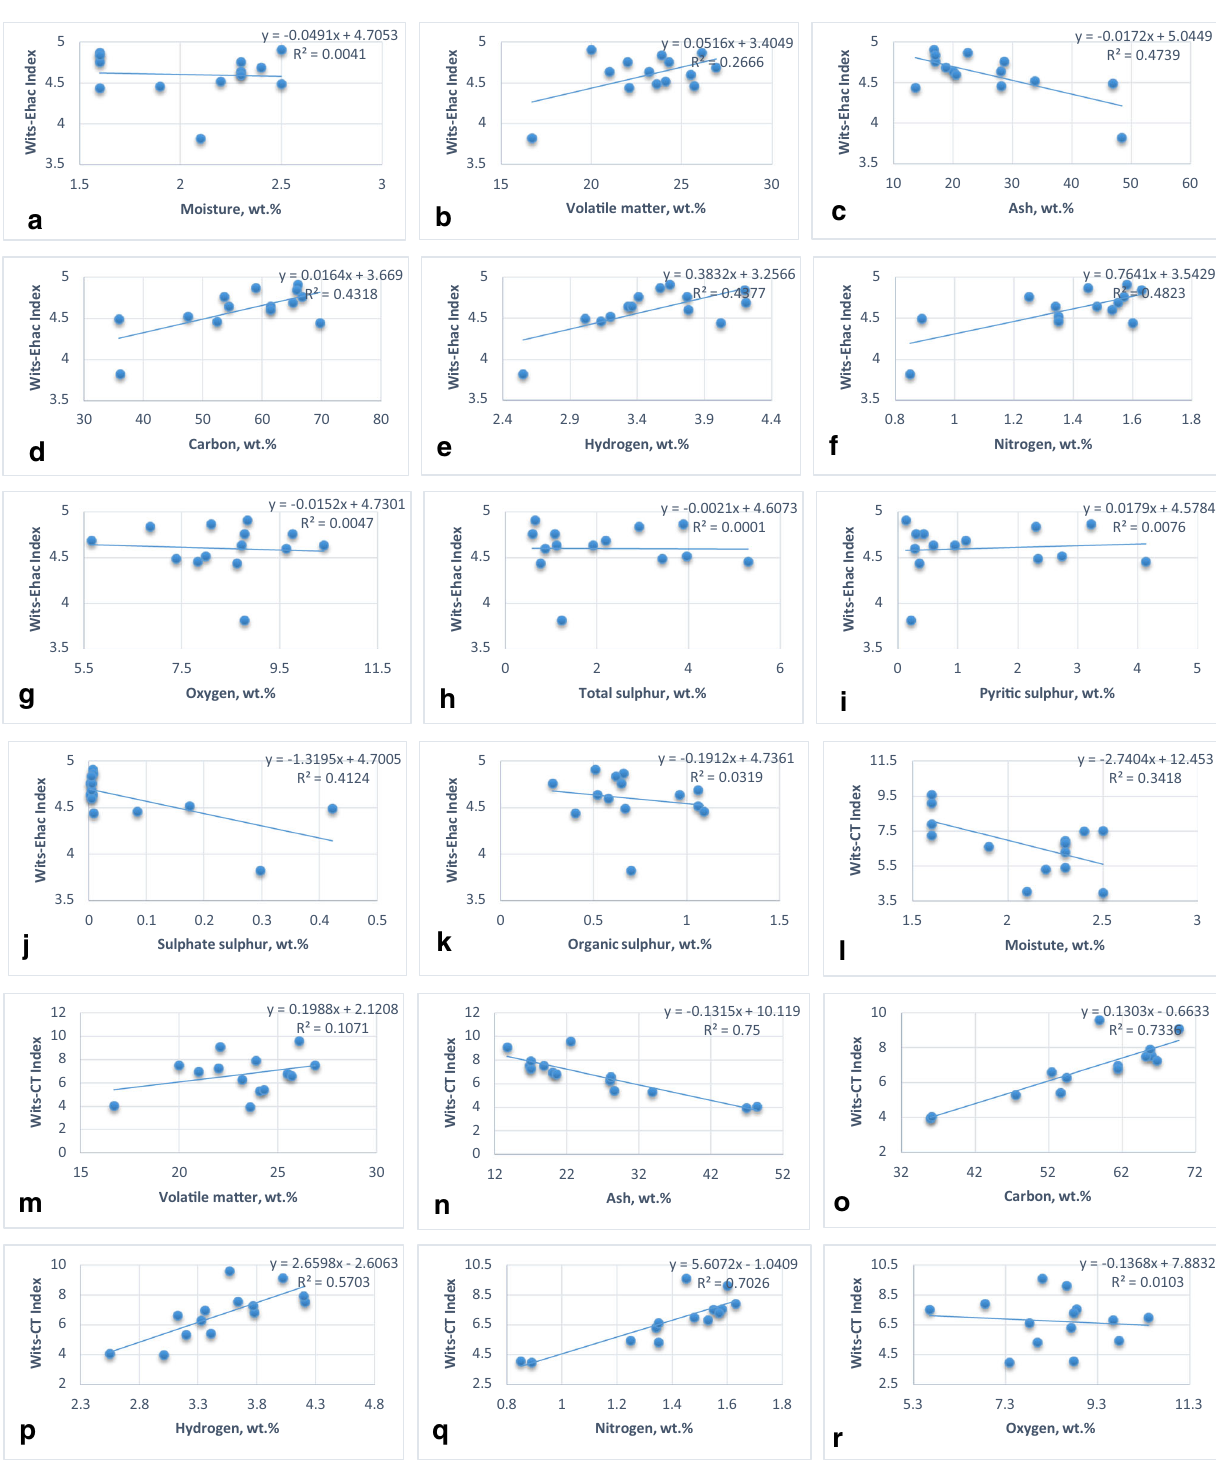
Fig. 5 Influence of proximate and ultimate analysis on spontaneous combustion of